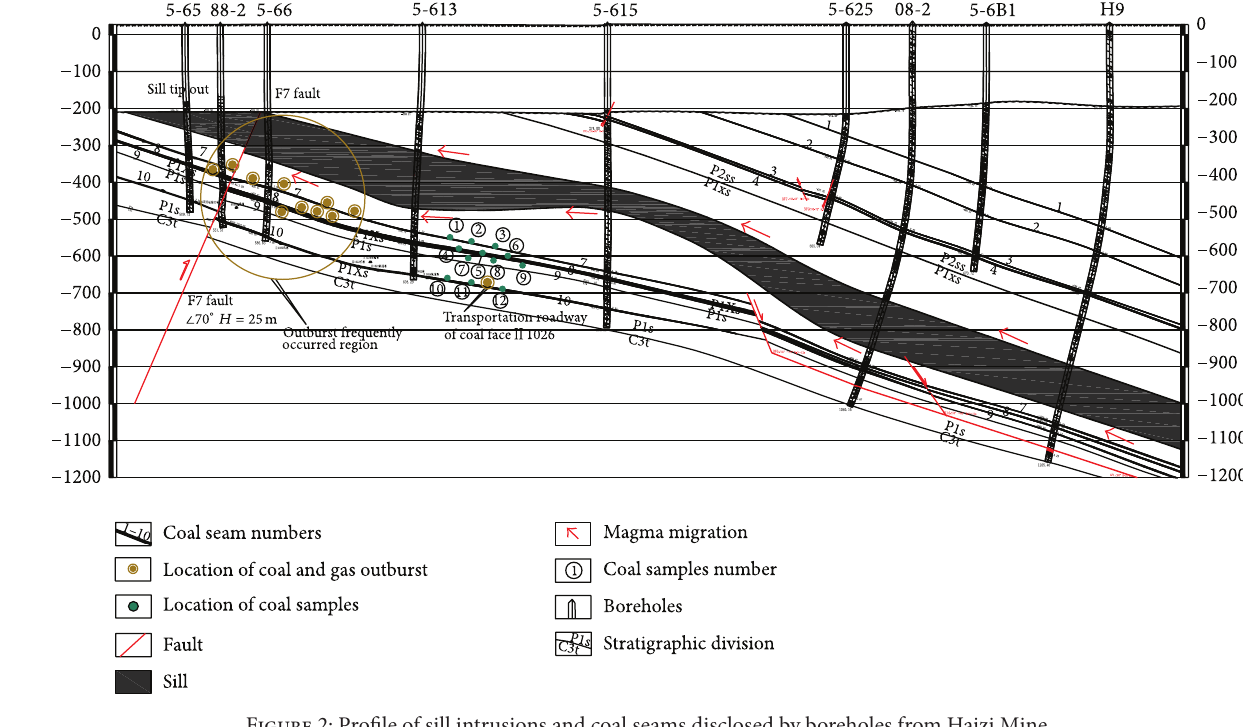
Figure 2: Profile of sill intrusions and coal seams disclosed by boreholes from Haizi Mine. Table 1: Geochemical and petrographic analyses of Haizi coal